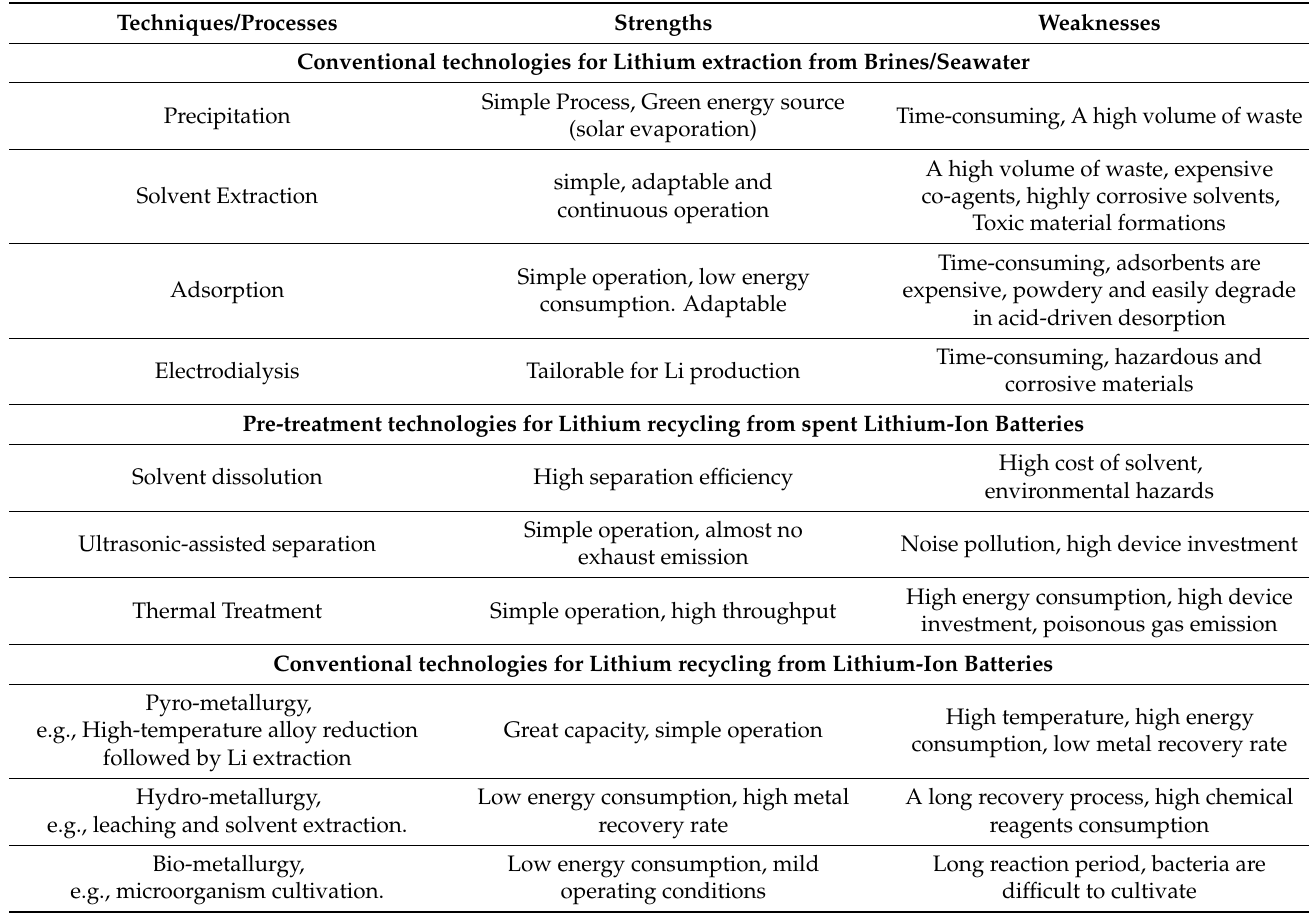
Figure 3. A schematic diagram summarizing the commonly used techniques for lithium harvesting. Table 1. Summary of strengths and weaknesses of using old conventional methodologies for Li harvesting from Sea-water brines and